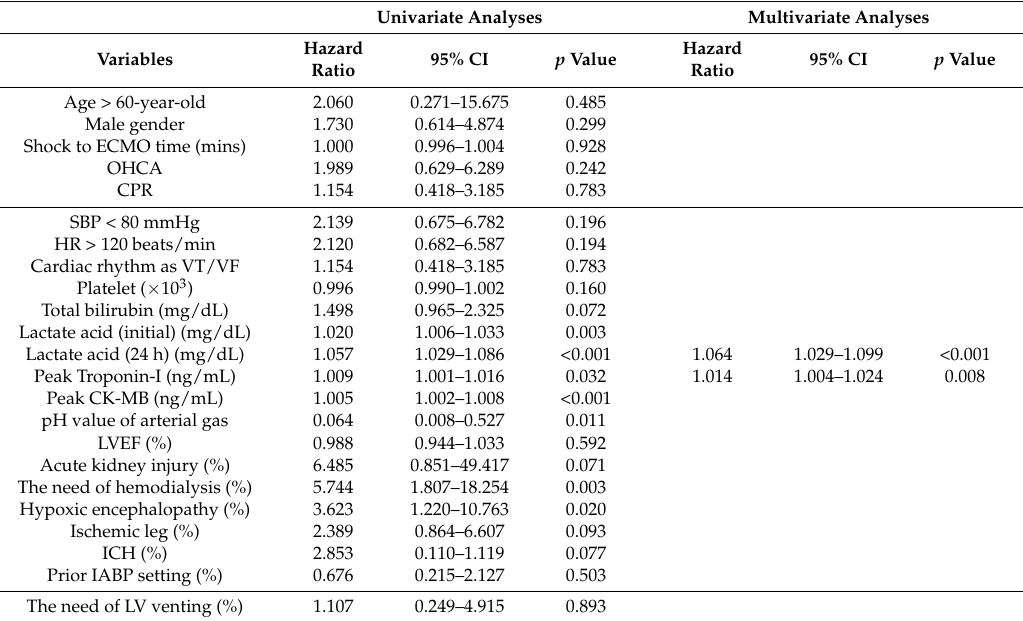
Table 2. Univariate and multivariate Cox regression analyses for in-hospital all-cause mortality. Univariate